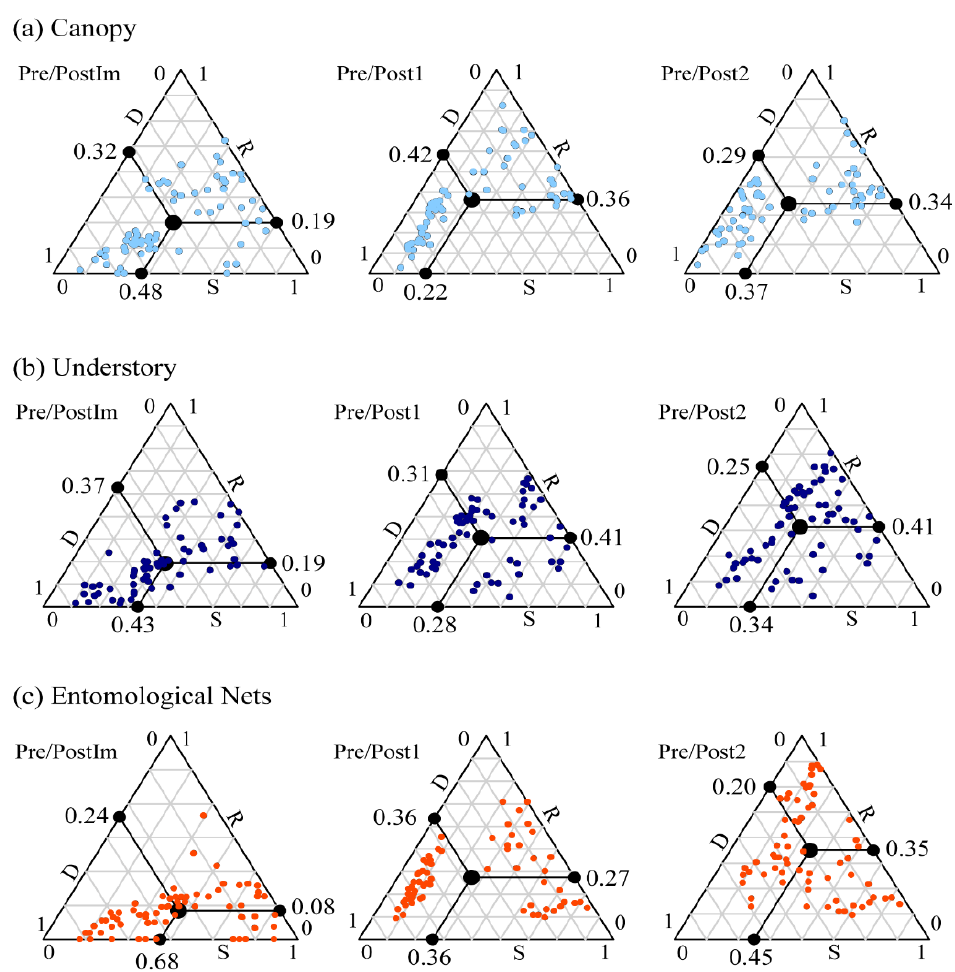
Figure 4. SDR-simplex plots generated from pairwise comparisons before (Pre, PostIm, Post1, and Post2) after the creation of the Santo Antônio dam on the Madeira River in southwestern Amazonia, Brazil. The graphs axes represent: S (similarity), D (Abundance Difference), and R (replacement). The three different sampling techniques were ( a ) canopy, ( b ) understory, and ( c ) entomological nets. The values are based on the Ruzicka dissimilarity matrix for abundance data. Each point represents a pair of sites and the large central dot in each triangle represents the centroid of the points.